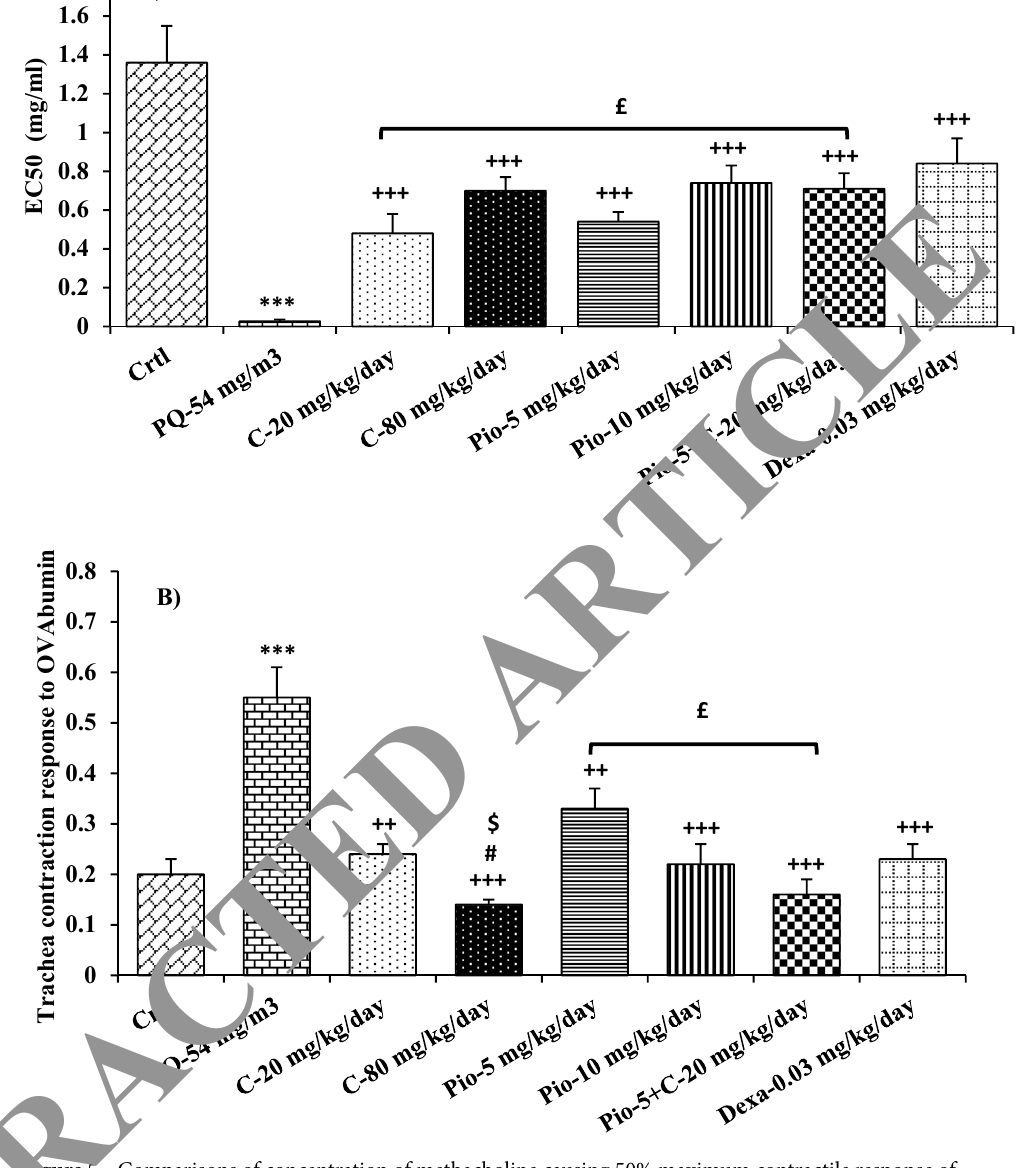
Figure 5. Comparisons of concentration of methacholine causing 50% maximum contractile response of tracheal smooth muscle to methacholine (EC 50 ) ( A ), and tracheal contractile response to ovalbumin (OVA), ( B ) between control group (Ctrl), group exposed to paraquat aerosol at doses of 54 mg/m 3 (PQ-54 mg/m 3 ), groups exposed to PQ-54 mg/m 3 and treated with 5 and 10 mg/kg/day pioglitazone (Pio-5 mg/kg/day and Pio-10 mg/kg/day), 20 and 80 mg/kg/day carvacrol (C-20 mg/kg/day and C-80 mg/kg/day), 0.03 mg/kg/day dexamethasone (Dexa-0.03 mg/kg/day) and 5 mg/kg/day pioglitazone + 20 mg/kg/day carvacrol (Pio-5 mg/ kg + C-20 mg/kg). *** p < 0.001 compared to the control group. ++ p < 0.01, and +++ p < 0.001 compared to PQ-54 mg/m 3 , # p < 0.05 compared to dexamethasone, $ p < 0.05 compared to C-20 mg/kg/day, £ p < 0.05 comparison between Pio-5 and C-20 with Pio-5 mg/kg/day + C- 20 mg/kg/day group. Data are presented as mean ± SEM (n = 6 in each group). Comparisons between different groups were made using one-way ANOVA followed by Tukey’s multiple comparison